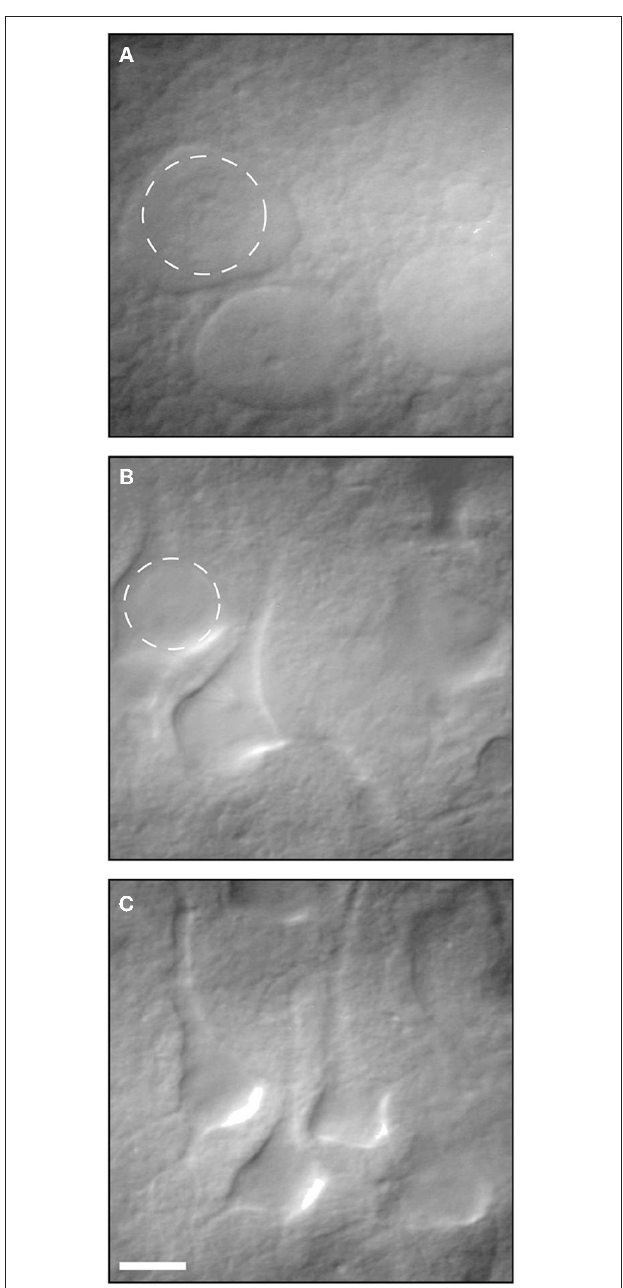
FIGURE 2 | Infrared differential interference contrast (IR-DIC) video micrographs of neurons in 400- μ m-thick brain slices. (A) Several examples of dead neurons. (B) Several examples of unhealthy neurons. (C) Examples of healthy patchable neurons. Reproduced with permission from Moyer and Brown